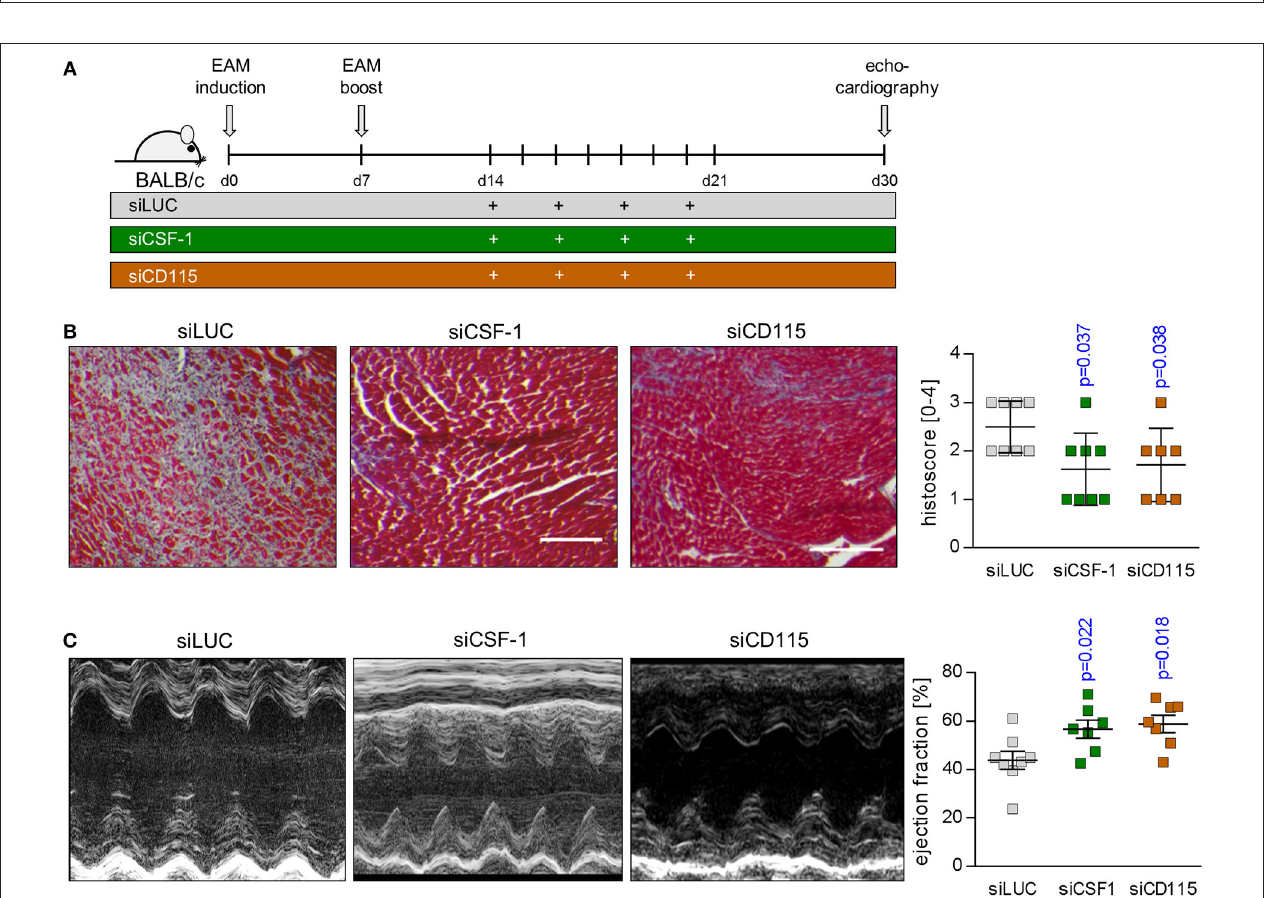
FIGURE 6 | to its potential to manipulate EAM in comparison to siLUC (control). Therefore, mice were treated with 0.5 mg/kg siRNA intravenously every other day starting 14 days after EAM induction, and mice were sacrificed 21 days after the first immunization. (B) Representative dot plots (left) and enumeration (right) of inflammatory Ly6C hi monocytes in heart tissue of siLUC- and siCSF-1-treated mice ( n = 8). (C) Representative dot plots (left) and quantification of granulocyte-monocyte progenitors (GMPs) (right) found in bone marrow of siLUC- and siCSF-1-treated mice during EAM ( n = 12). (D) Representative FACS plots (left) and quantification (right) of BrdU incorporation in GMPs of the bone marrow in siLUC- and siCSF-1 treated mice ( n = 8). (E) Representative FACS density plots (left) and quantification of monocytes/macrophages (right) in the blood of siLUC- and siCSF-1- treated mice ( n = 7). Unpaired t- tests were used. p -values are indicated on the graph and significant differences ( p < 0.05) are marked with blue color.